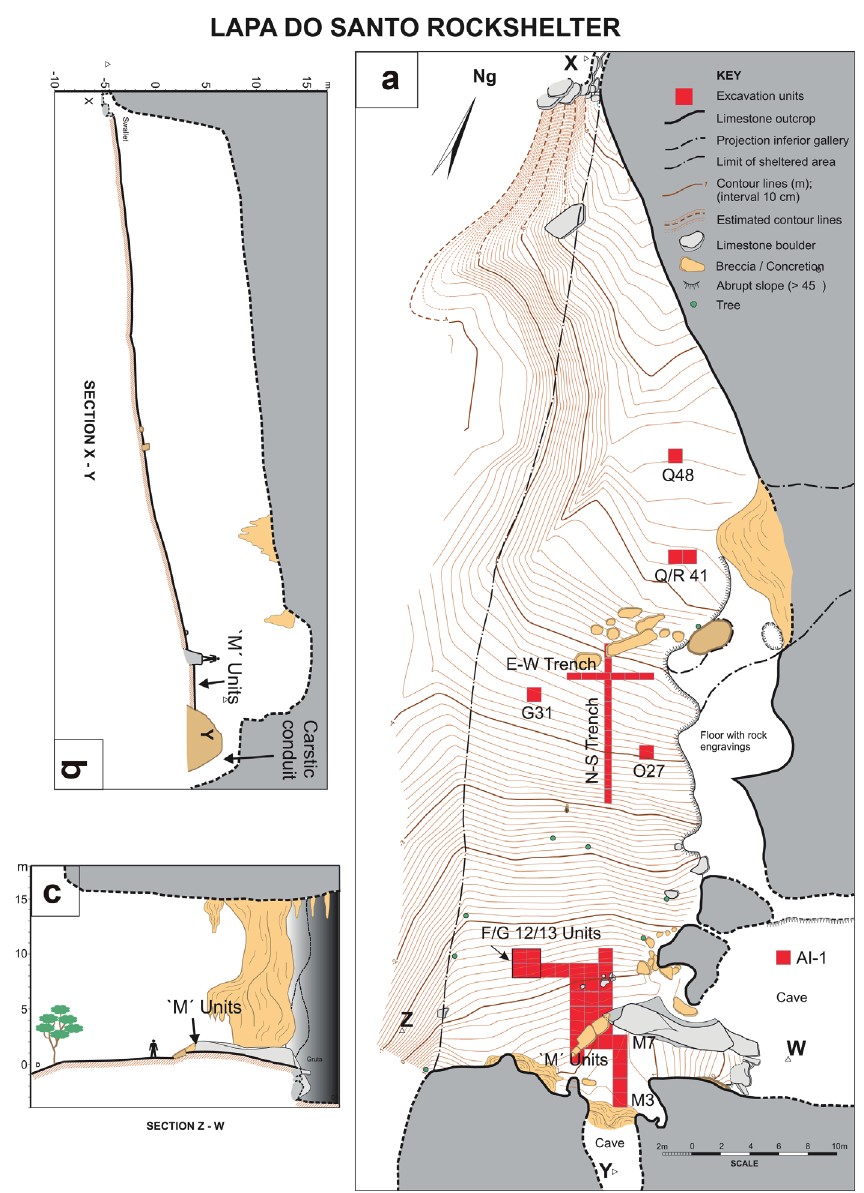
Figure 3 - Map of Lapa do Santo rockshelter, showing the excavation areas and topographic